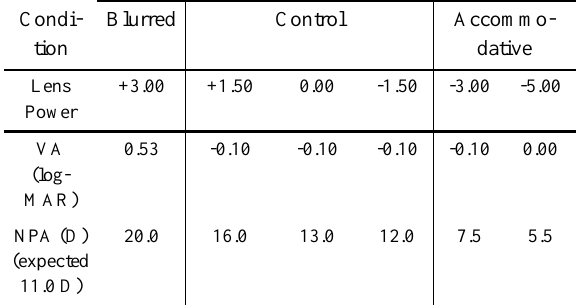
Figure 2. Fixation stability were different across